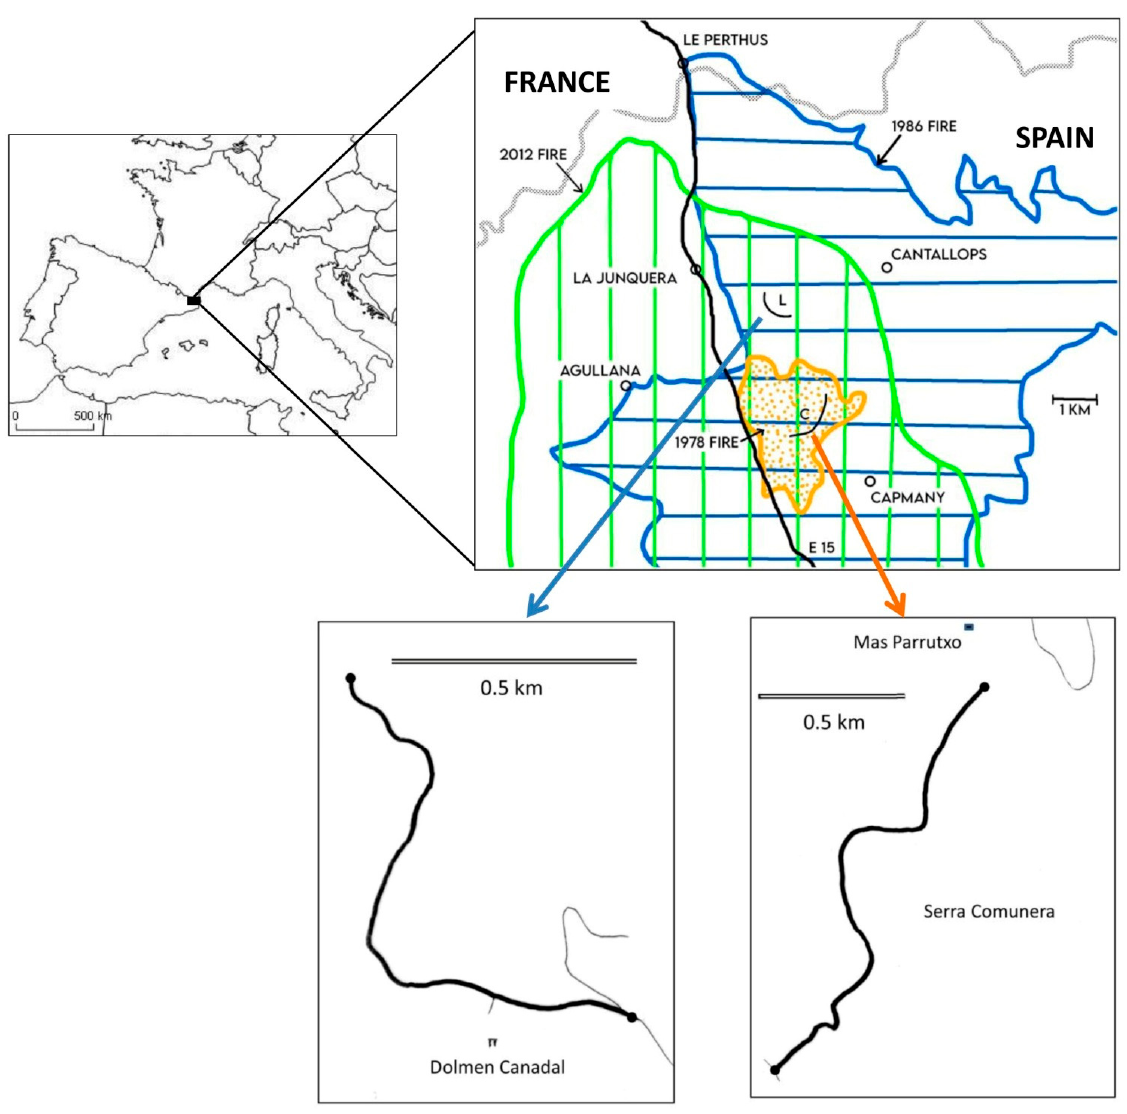
Figure A1. Location of the study area, mapping of the three studied fires (1978, 1986, 2012) in their overlap area, and layout of the transects ‘L’ and ‘C’ (their coordinates are given in the text). Hand-drawn map; fire boundaries approximate.